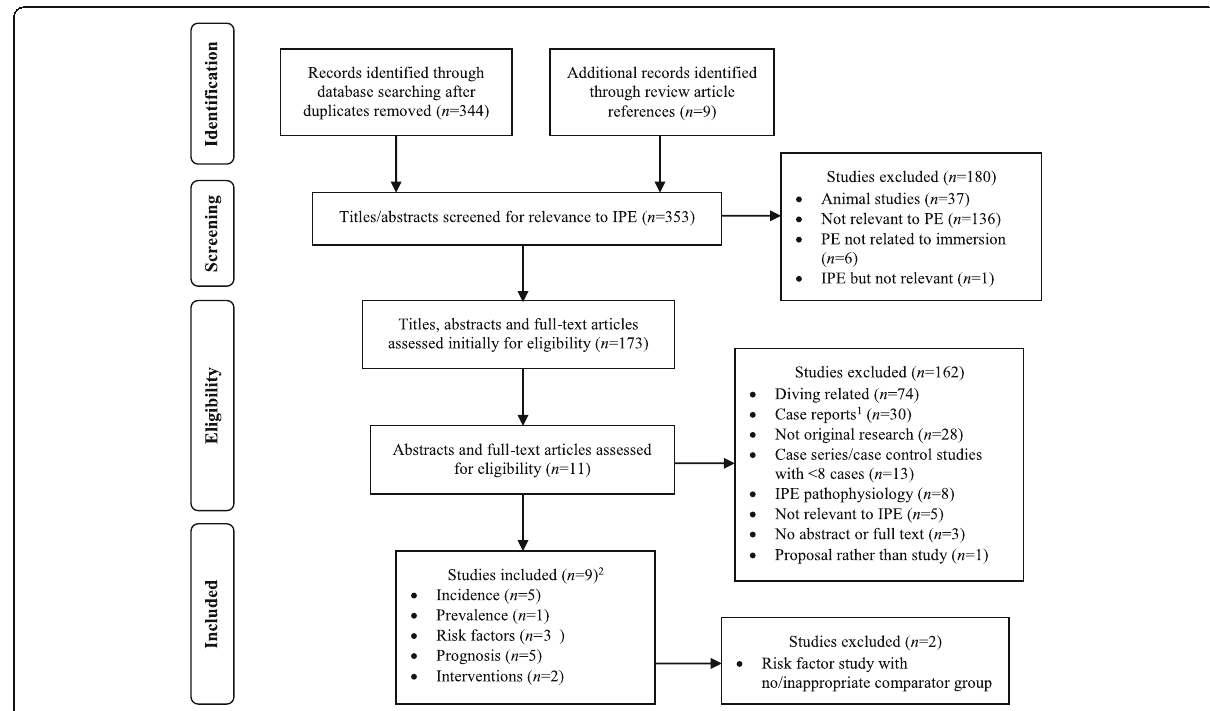
Fig. 1 PRISMA flow diagram. PRISMA preferred reporting items for systematic reviews and meta-analyses; PE pulmonary edema; IPE immersion pulmonary oedema. 1 One case report was included in the interventions section due to a lack of relevant studies. 2 Numbers do not add up